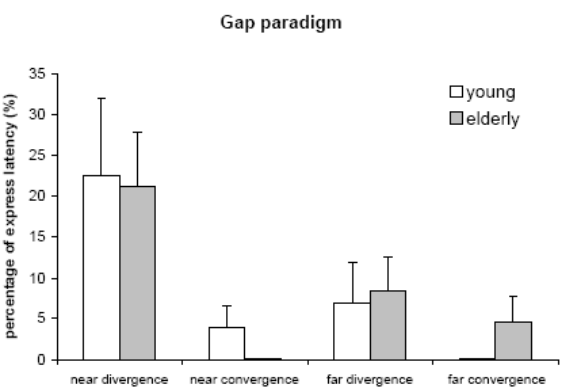
Figure 5. Percentages of express latencies of convergence and divergence for both young and elderly subjects. Near diver- gence starting from point at 20 cm; near convergence starting from point at 40 cm; far divergence starting from point at 40 cm; far convergence starting from point at 150 cm. Percentages of express latency of near divergence are significantly higher than those of other type of vergence for both young and elderly subjects (both